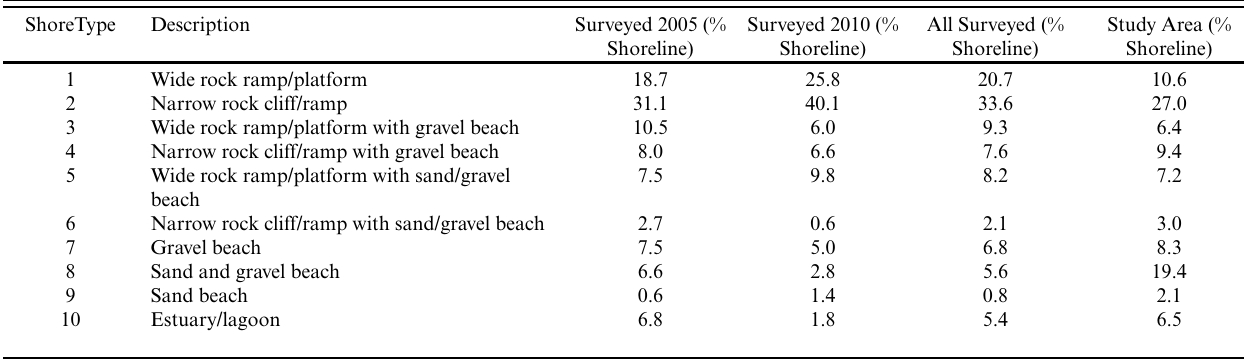
Table 4 . Percent shoreline for each shoreline type (ShoreType) over different extents of study area. Surveyed 2005: shoreline surveyed in 2005 by Canadian Wildlife Service (south of Juan Perez); Surveyed 2010: shoreline surveyed in 2010 by Laskeek Bay Conservation Society (Juan Perez and Laskeek Bay regions); All surveyed: all surveyed shoreline combined; Study Area: all shoreline in study area including surveyed and unsurveyed, i.e., predicted, shoreline.